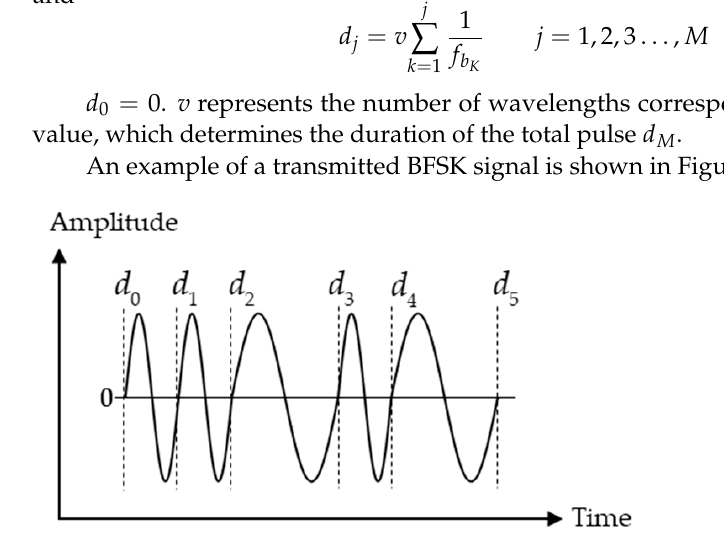
Figure 14. Transmitted BFSK signals with a binary code of 11010 ( d 0 = d 1 = d 3 = 0 and the corresponding frequency is f 0 , d 2 = d 4 = 1 and the corresponding frequency is f 1